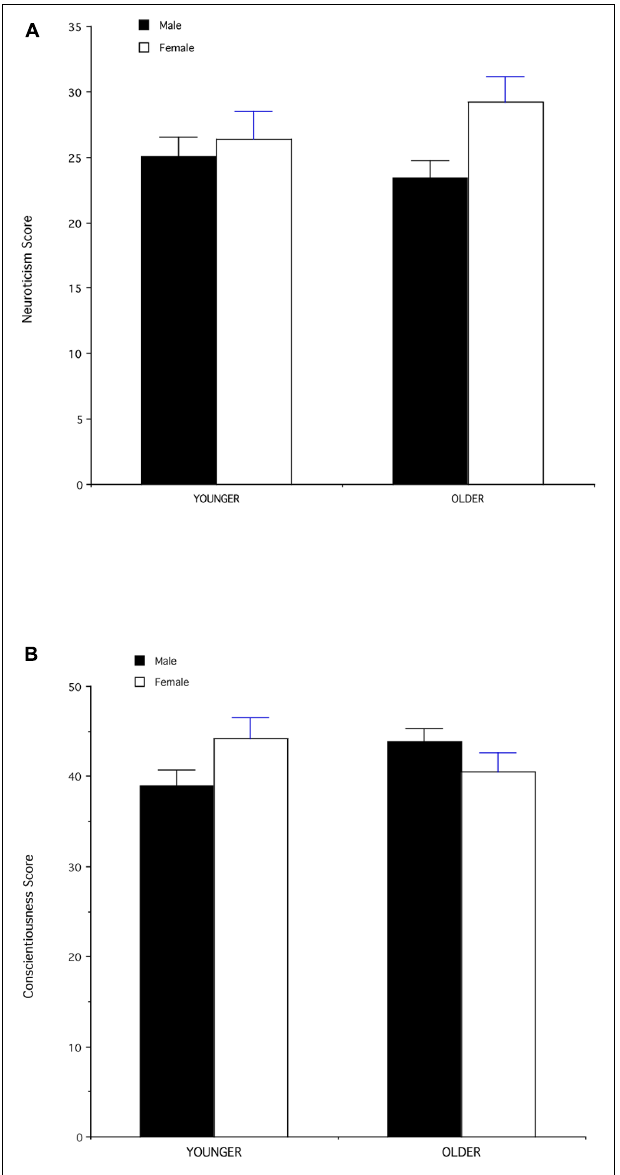
FIGURE 3 | (A) Mean ( + SEM) values of neuroticism score (number of respondents who rated stimuli as secure/confident) for male and female face stimuli in the younger (35–50 years) and older (51–65 years) age groups. (B) Mean ( + SEM) values of conscientiousness score (number of respondents who rated stimuli as efficient/organized) for male and female face stimuli in the younger (35–50 years) and older (51–65 years) age